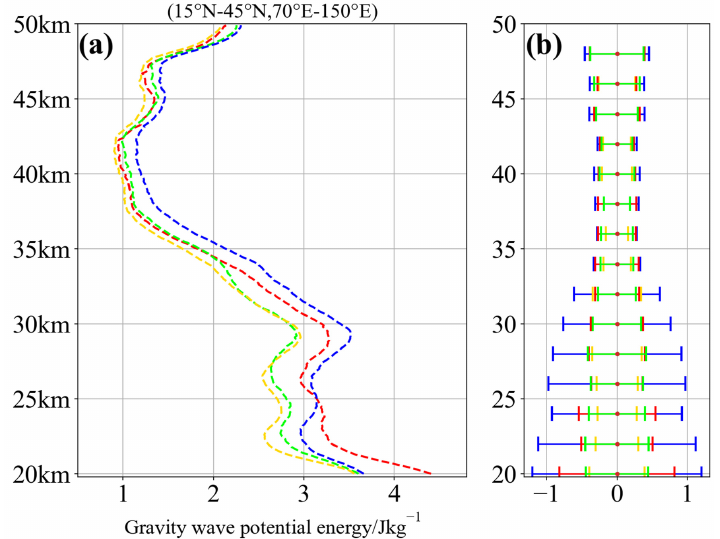
Figure 2. ( a ) Regional seasonal mean profiles of Ep for winter (DJF; December – January – February), spring (MAM; March – April – May), summer (JJA; June – July – August), and autumn (SON; September – October – November). ( b ) The standard deviation relative to the mean at each height (the absolute value of the length of the error bar is twice the standard deviation).